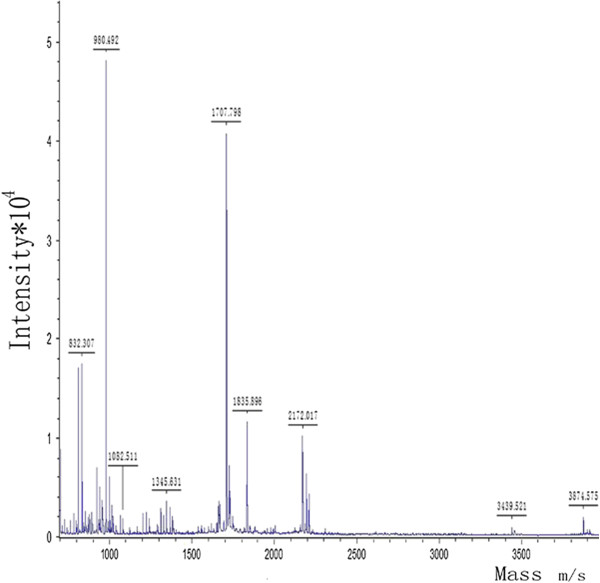
Representative MALDI-TOF peptide mass fingerprint spectrum of spot b. After trypsin digestion, the resulting peptides were analysed by MALDI-MS and MS/MS analyses. Peptide mass fingerprints (PMFs) data were searched against the database of SwissProt by BioTools 3.0 software. The protein with molecular mass of approximately 42 kDa was identified as haptoglobin (Hp) by the sequence analysis.